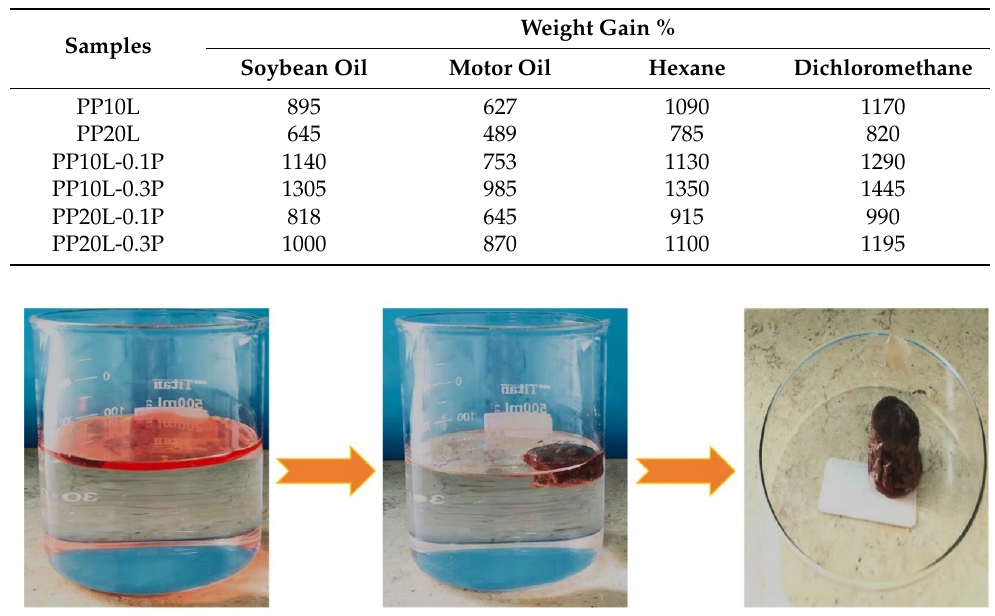
Figure 11. Absorption capacities of polypropylene and blend sponges modified with POSS. ( a ) Soybean oil, ( b ) engine oil, ( c ) hexane, and ( d ) dichloromethane. Table 6. Weight gain of sponges with tested liquid (soybean oil, motor oil, hexane, and dichloromethane).